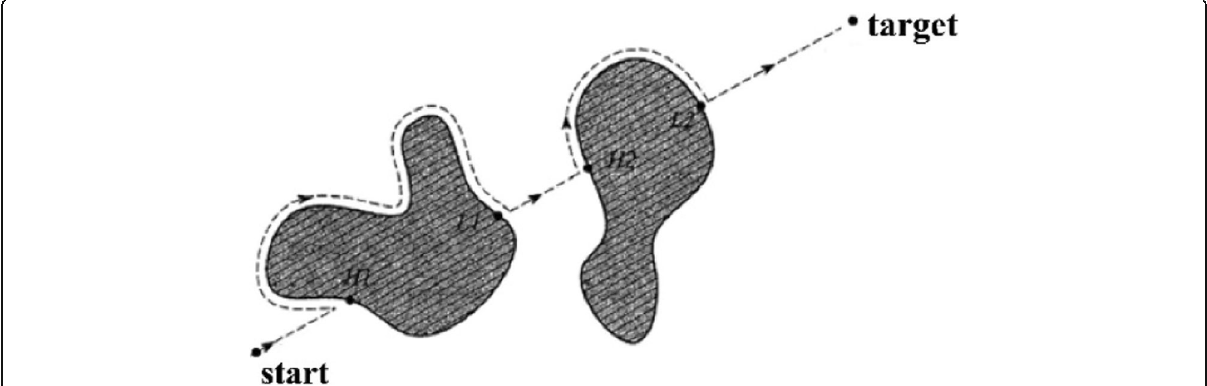
Fig. 2 Bug2 algorithm with two points H1 and H2 as collision points. L1 and L2 are selected as the exit